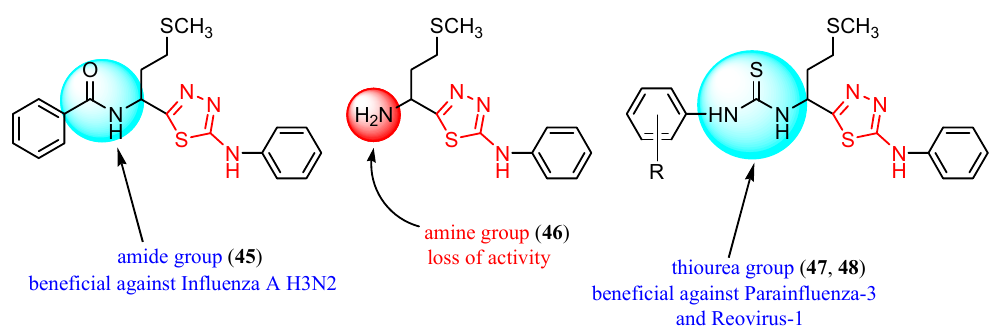
Figure 5. The influence of substituents of 1,3,4-thiadiazole derivatives 45 – 48 on anti-respiratory viruses’ activity.